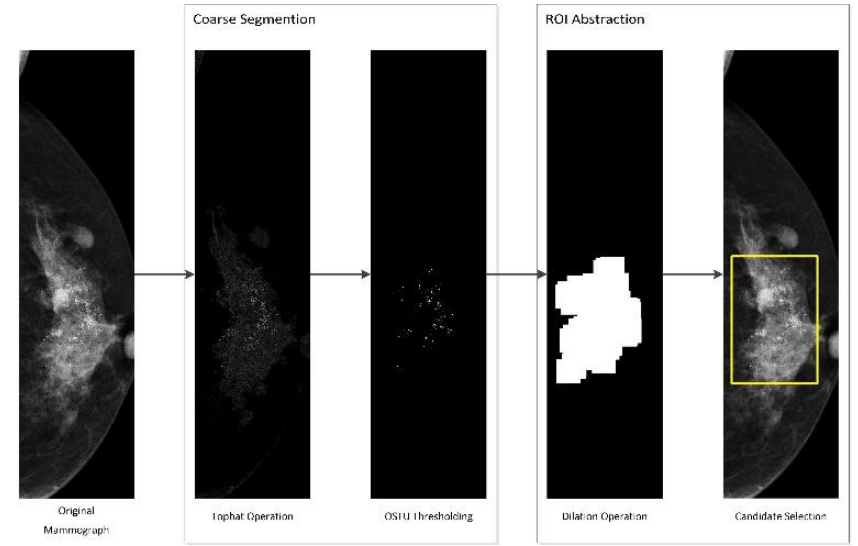
Figure 1. Workflow diagram for ROI abstraction.